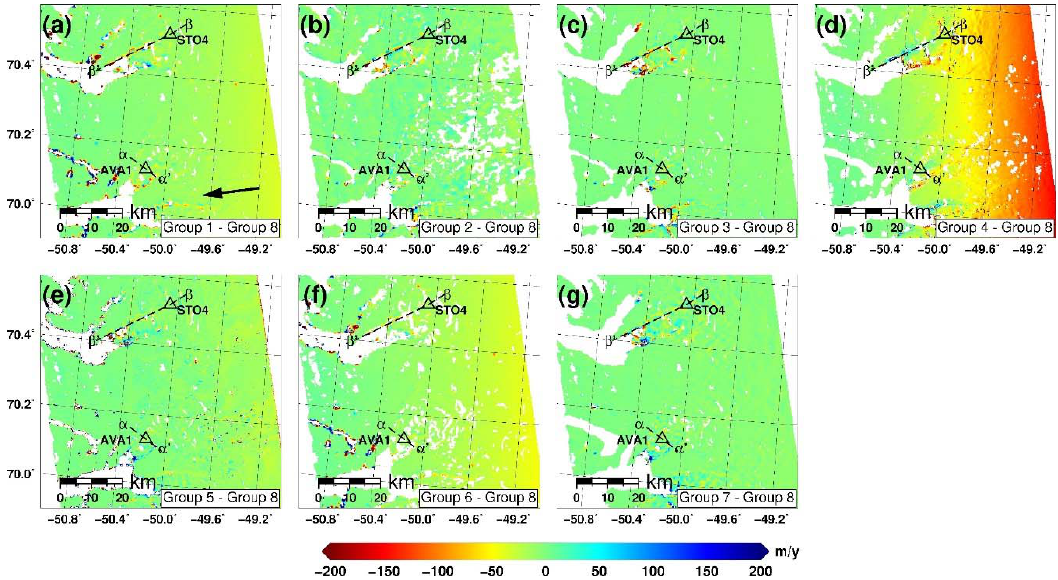
Figure 18. Task 4 LoS velocity differences between groups 1 to 7 ( a – g ) with respect to group 8 in the area of GPS stations STO4 and AVA1. The dashed lines represent the traces of the profiles in Figure 24a,c.